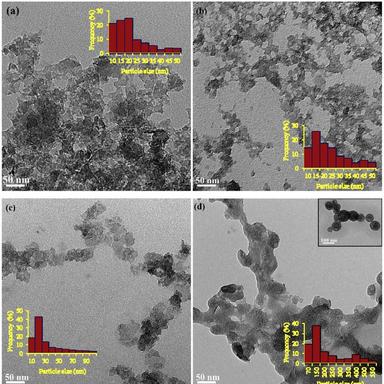
Typical TEM micrographs and respective particle size distribution of the as-synthesized aluminum hydroxides aged for (a) 1 h, (b) 48 h; and alumina samples prepared after calcination of (c) 1-h aged aluminum hydroxide, and (d) 48-h aged aluminum hydroxide. (Magnification: 35 kX).